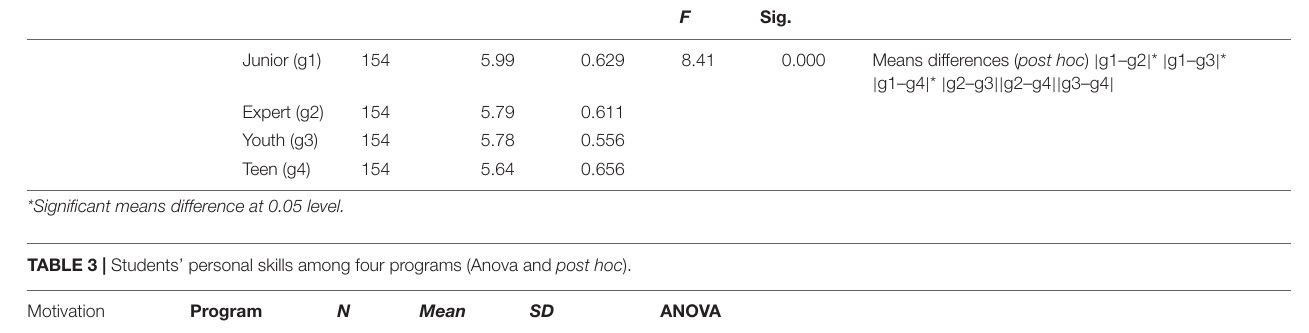
TABLE 2 | Teachers’ satisfaction among four programs (Anova and post hoc ). Teacher satisfaction